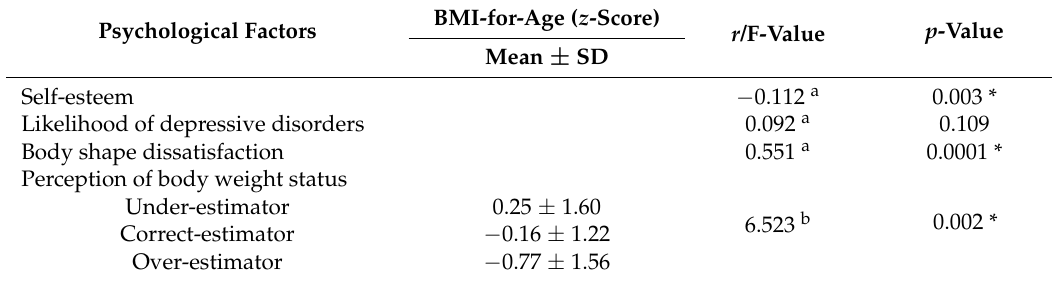
Table 3. Association between psychological factors and BMI-for-age ( z -score) ( N =